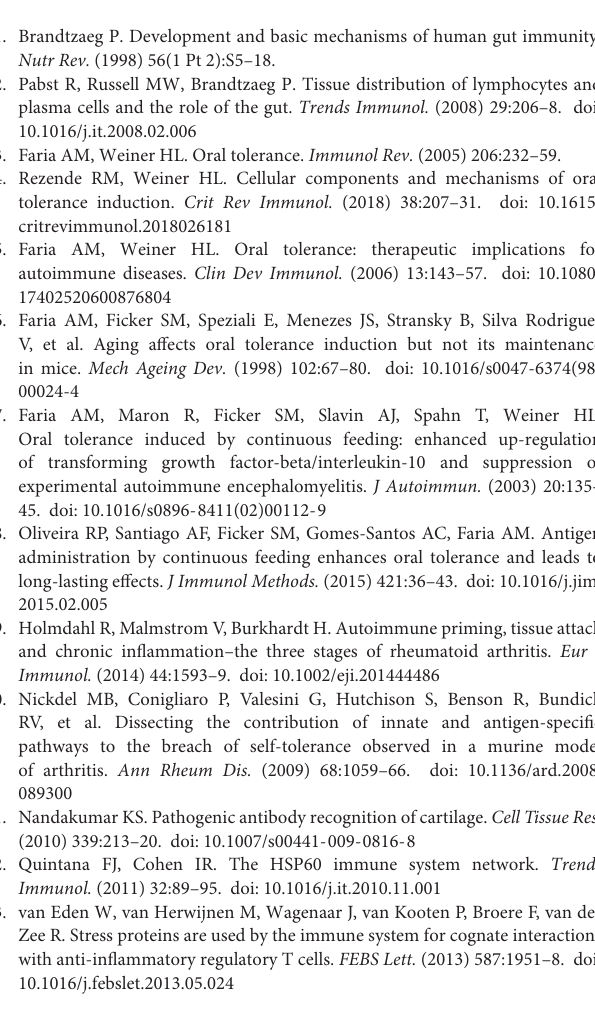
FIGURE S3 | Effector CD4 + T cells in mice with either chronic arthritis (CIA) or acute arthritis (mBSA-induced) treated with HSP65-producing L.lactis. Activation of naive CD4 + T cell into effector cell was analyzed by measuring the frequency of CD4 + CD44 + CD62L-cells in spleen (A) of BALB/c with CIA at days 42 and 95 after disease induction using flow cytometry. BALB/c mice were fed either XM17 broth only (C group), L. lactis -EP (EP group) or Hsp65-Lac (HSP group) for four days and immunized for arthritis (CIA) induction 10 days thereafter. Frequencies of spleen (B) and mesenteric lymph nodes (C) activated CD4 + CD44 + CD62L-cells of C57BL/6 mice with mBSA-induced arthritis were also analyzed by flow cytometry. C57BL/6 mice were fed either XM17 broth only (C group), L. lactis -EP (EP group) or Hsp65-Lac (HSP group) for four days. Ten days afterward, arthritis was induced by a subcutaneous immunization with mBSA in CFA. Two weeks later, mice were injected with mBSA directly into the knee and 24 h after they were euthanized. Graphs show the frequency of CD4-gated CD44 + CD62L-cells. Values represent the mean ± SEM. ∗ p < 0.05 compared to control C group. ∗∗ p < 0.005 compared to control C group. ∗∗∗ p <